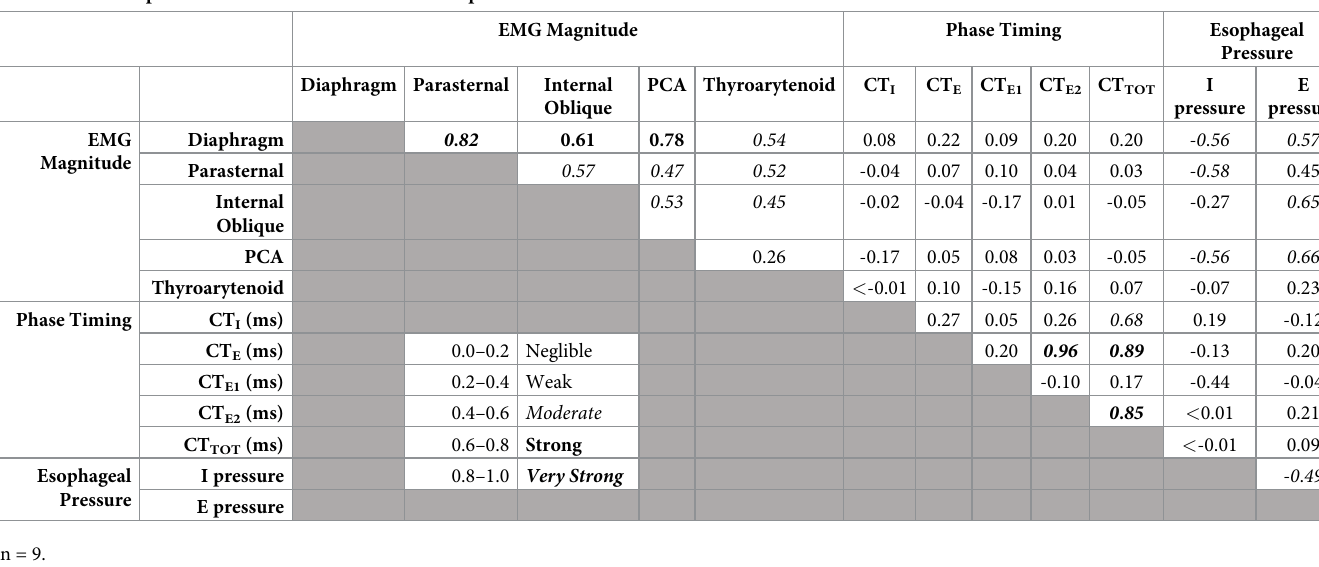
Table 3. Pearson product moment correlations for all dependent measures across all